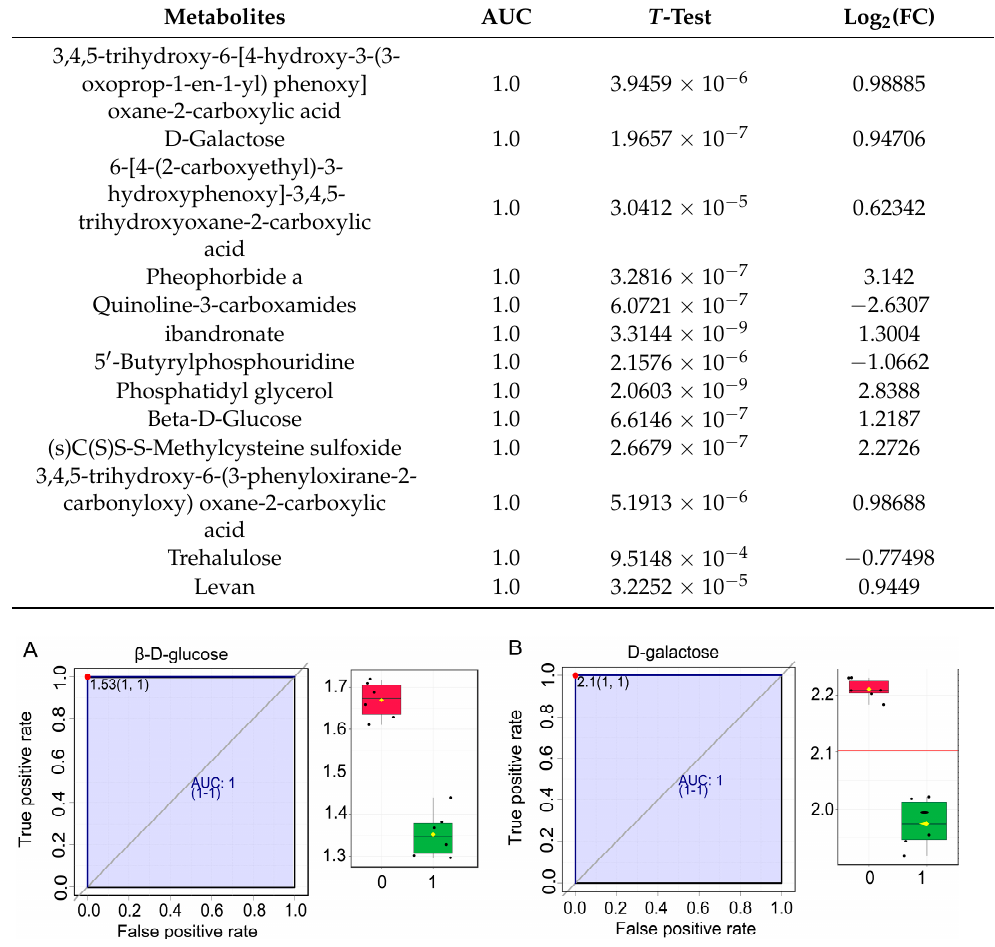
Figure 4. ROC and box plot of the biomarkers. ( A ) β -D-glucose. ( B ) D-galactose. The ROC curve closer to the left parietal corner indicates that the DAM has excellent sensitivity and specificity. The box plot intuitively shows the differences in expression abundance between the DAMs. The red box indicated 46 DAP, while the green one indicated 34 DAP. Table 1. Biomarker screening results by using MetaboAnalyst 5.0.